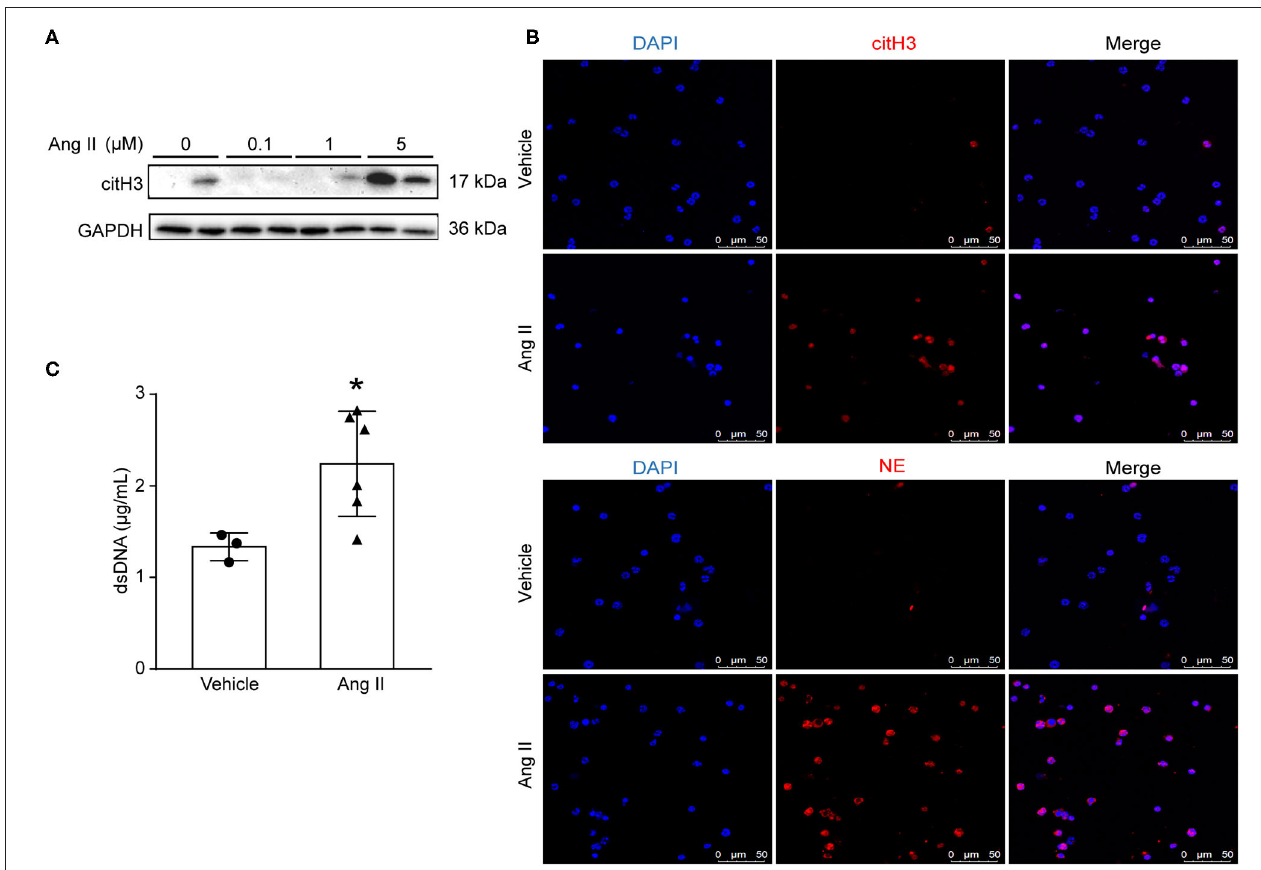
FIGURE 2 | Ang II induced NET formation in vitro . Neutrophils were isolated from ApoE − / − mice and treated with Ang II for 4h. (A) Western blot for citH3 in different concentrations of Ang II (0, 100nM, 1 µ M, and 5 µ M)-treated neutrophils. (B) Immunofluorescence analysis of Ang II (5 µ M)-treated bone marrow-derived neutrophils for citH3 (red) or NE (red). Nuclei were stained with DAPI. (C) Measurement of dsDNA in Ang II-treated neutrophils. n = 3/vehicle group, n = 6/Ang II group, * p < 0.05. Statistical significance was analyzed by the unpaired t -test.